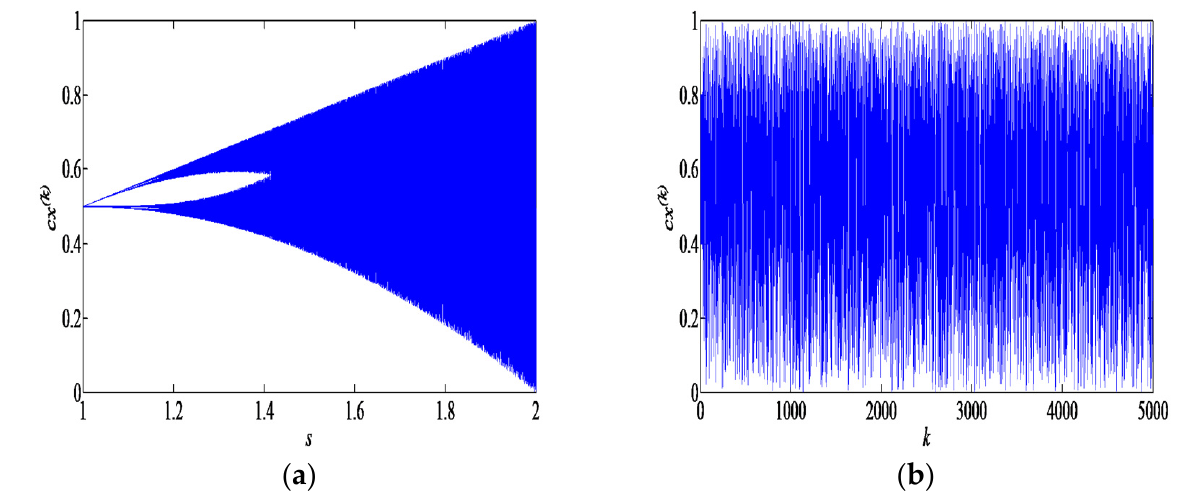
Figure 3. ( a ) Bifurcation diagram for the tent map; ( b ) Ergodicity and randomicity.